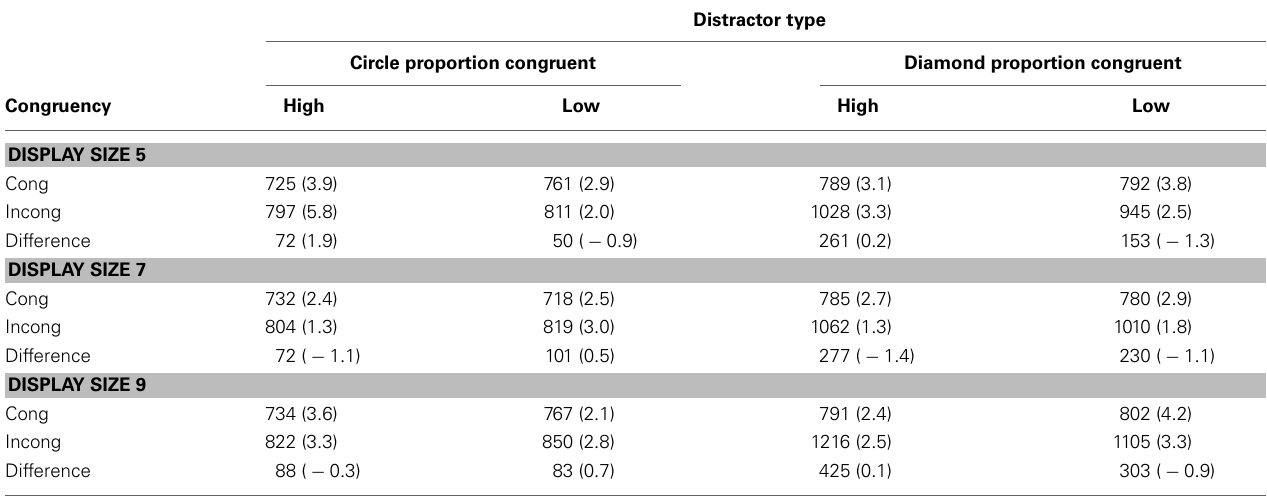
Table 3 | Mean response times and error percentages (in parentheses), collapsed across block, for each condition in Experiment 2.